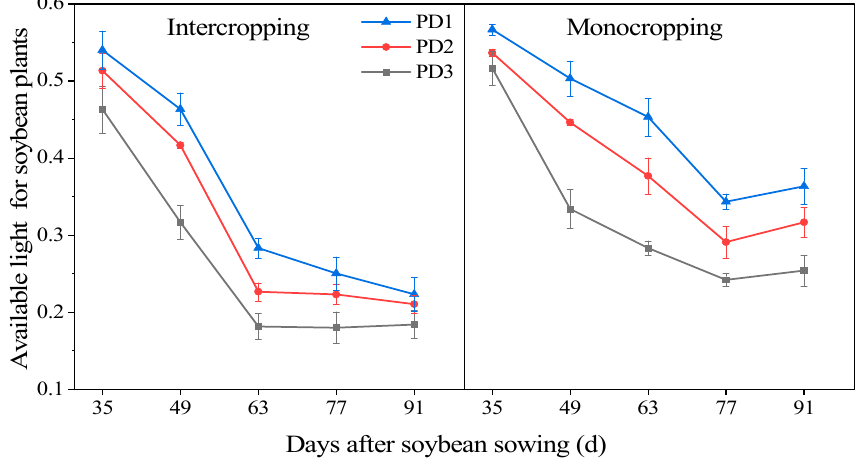
Figure 3. Effect of multiple planting densities (PD1 = 17, PD2 = 20, and PD3 = 25 plants m − 2 ) on the available light for soybean plants under both monocropping and strip intercropping system. All the values are means (±SE) standard error of three replications.